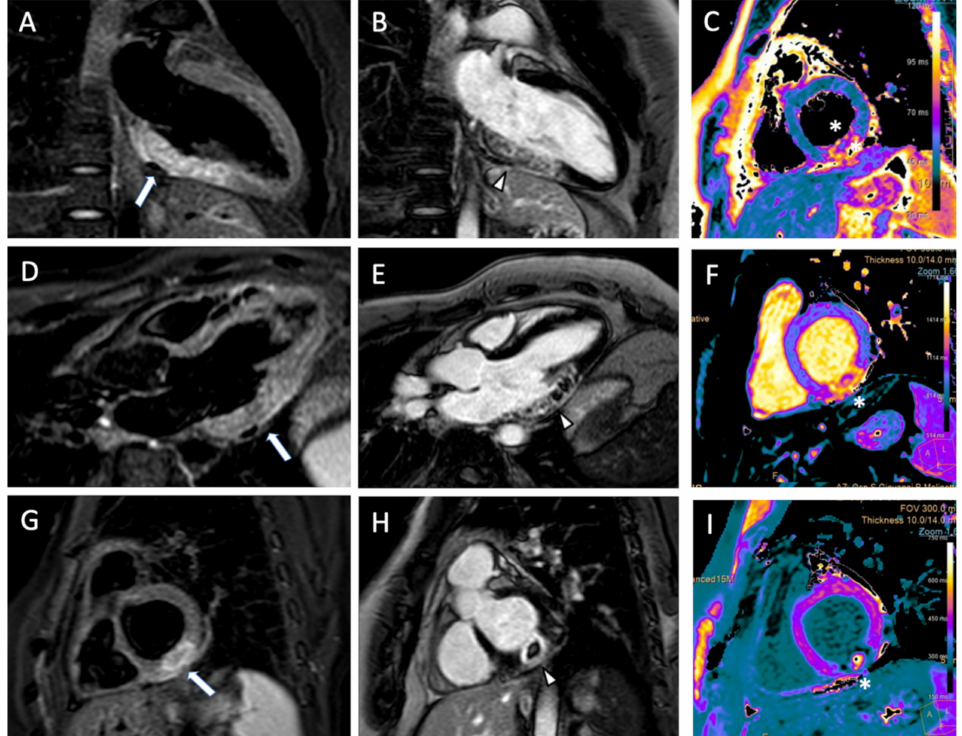
Figure 3. ( A ) 41 year old male patient underwent cardiac magnetic resonance for acute myocardial infarction. T2 black blood images show myocardial edema on inferolateral wall in two chamber (arrow, ( A )), three chamber (arrow, ( D )), and short axis (arrow, ( G )). The myocardial infarcted area with presence of microvascular obstruction was observed on late gadolinium enhancement in two chamber (arrowhead, ( B )), three chamber (arrowhead, ( E )), and short axis (arrowhead, ( H )). Microvascular obstruction was observed on short axis T2 mapping (asterisk, ( C )), native T1 mapping (asterisk, ( F ) e post-contrast native T1 (asterisk, ( I